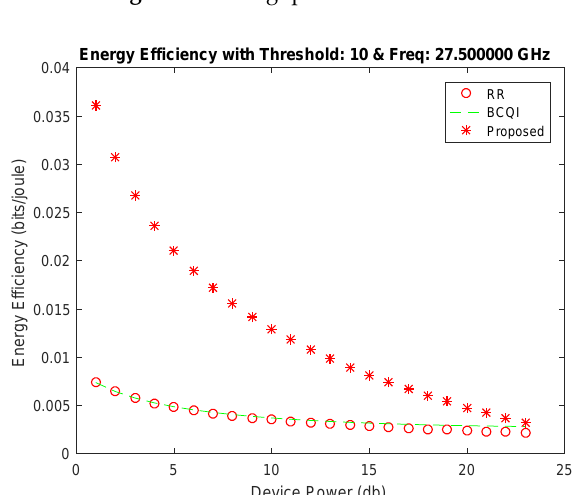
Figure 5. Throughput at threshold 6.